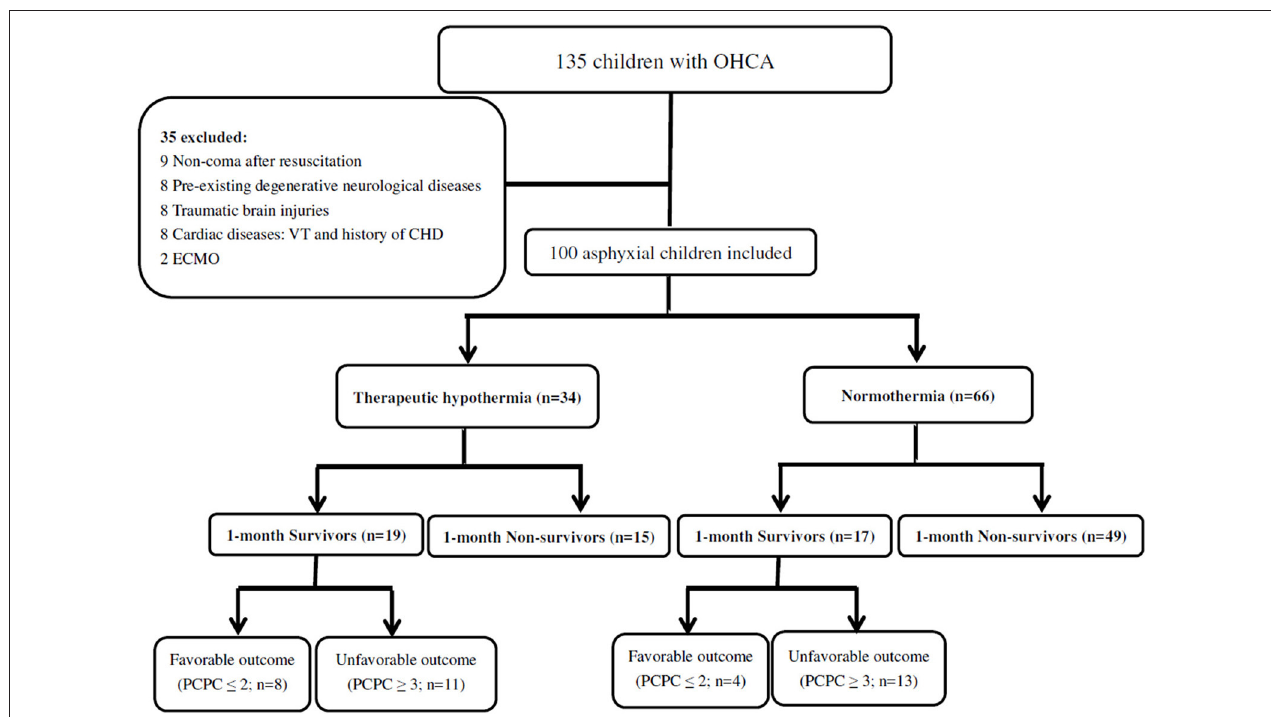
FIGURE 1 | A total of 135 patients with OHCA were identified. 100 asphyxial OHCA comatose patients were enrolled, including 36 patients who survival more than 1 month and 64 patients who died within 1 month. The overall 1-month survival rate was 36%. The patients with 6-month neurological outcomes included those who died during the follow-up period. Eight (23.5%) of the thirty-four patients had favorable outcome (PCPC ≤ 2) in therapeutic hypothermia group and 4 (6.1%) of the 66 patients had favorable outcome (PCPC ≤ 2) in normothermia group. (OHCA, out-of-hospital cardiac arrest; PCPC, pediatric cerebral performance category; VT, Ventricular tachycardia; CHD, congenital heart disease; ECMO, Extracorporeal Membrane